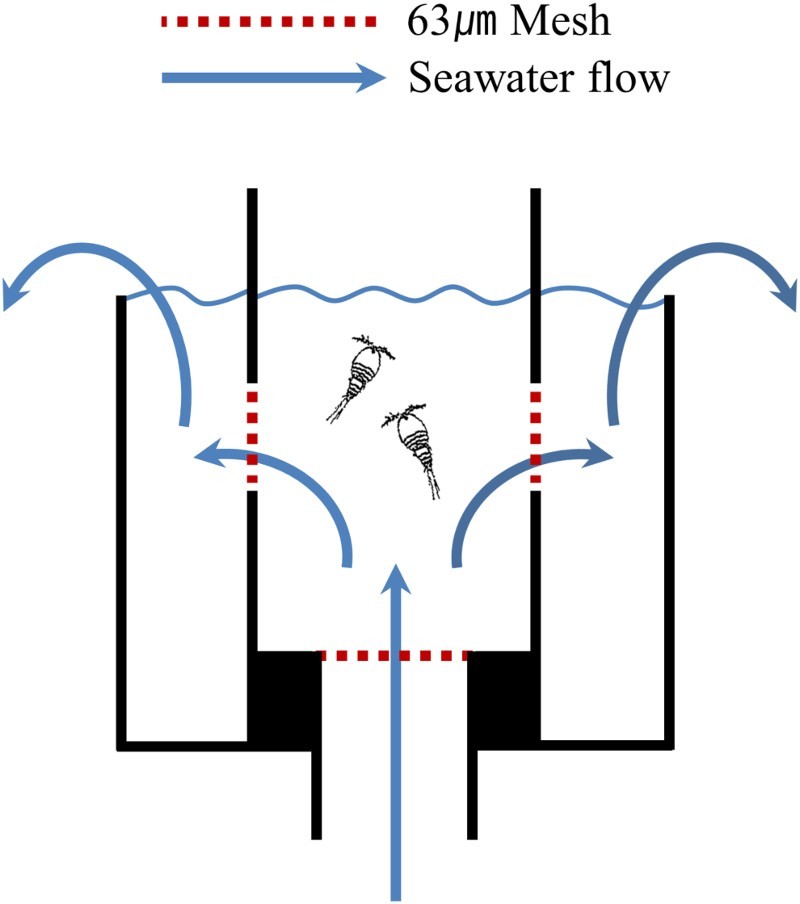
Experimental chamber set.